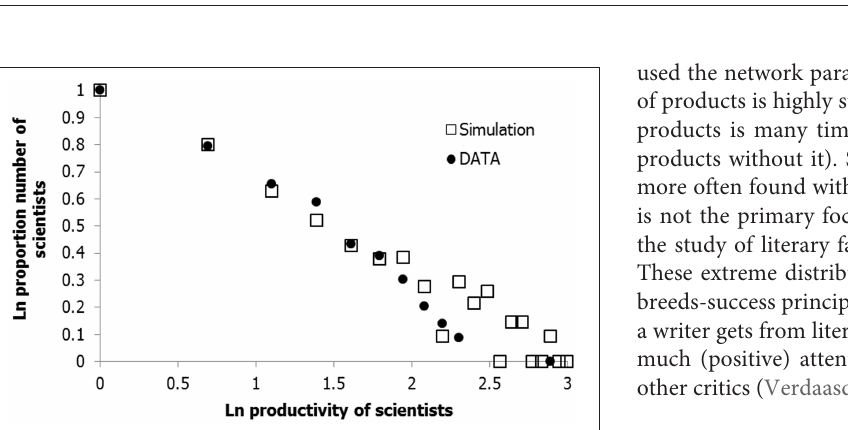
a tenacity factor (M) (Huber, 2000; Huber and Wagner-Dobler, 2001). The tenacity factor is represented by an arbitrarily